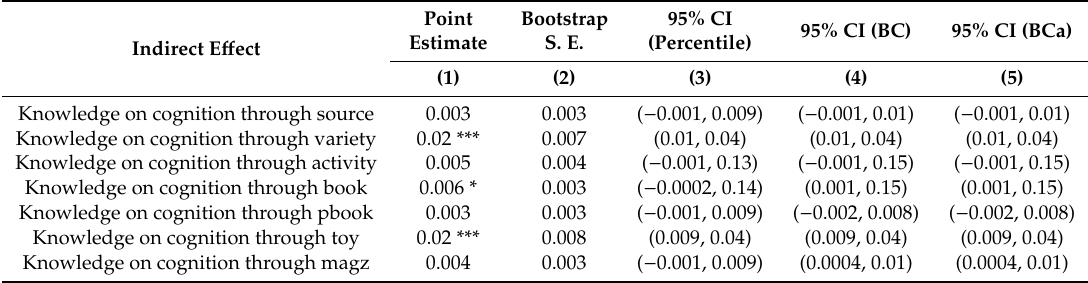
Table 4. Estimates of indirect e ff ects of parenting knowledge on cognitive development through di ff erent parental investments.